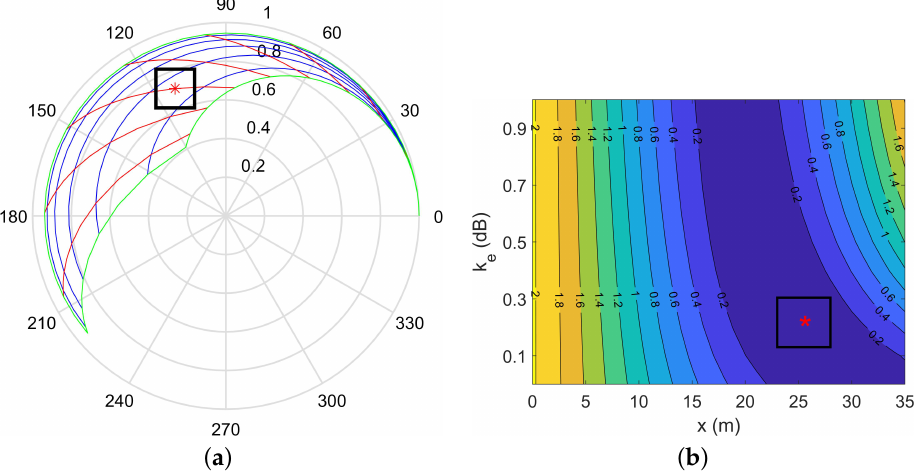
Figure 7. Different representation of the loss function with θ = π /4, k z = 0.12 m − 1 . The red asterisks denote the location of the observed coherence which is also the optimal solution. The black rectangles indicate the neighborhood near the optimal solution. ( a ) Geometrical representation of the loss function. The area enclosed by the green line is the solution space where the coherences are calculated by Equation (6). The blue line denotes the direction of h v . The red line presents the direction of k e . ( b ) The contour of the loss